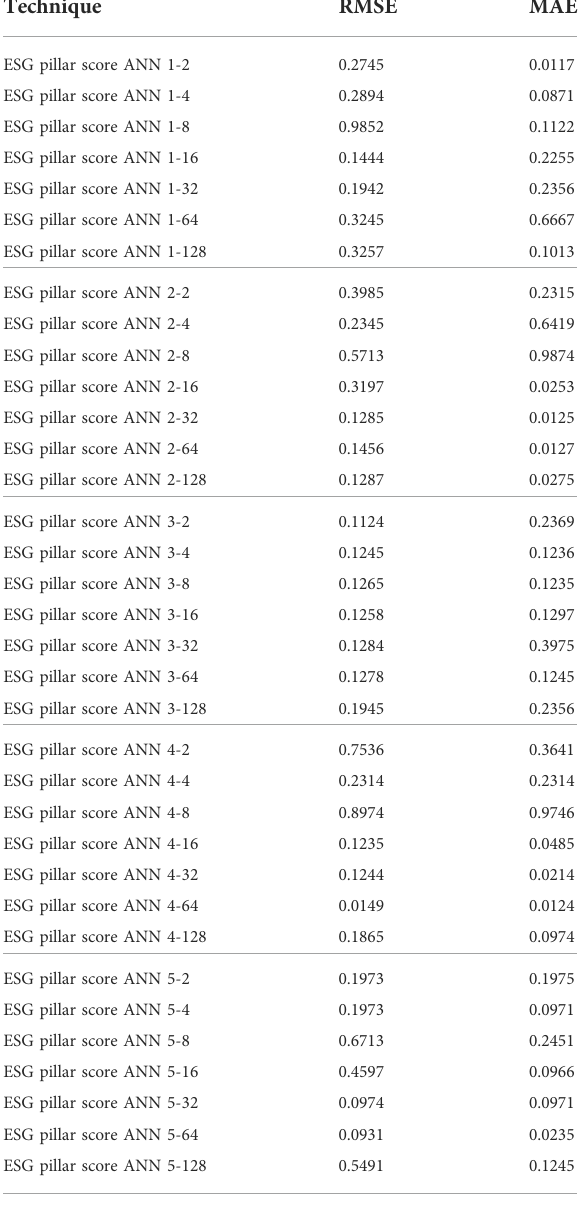
TABLE 3 Result of ESG pillar score error measurement using the ANN Technique.